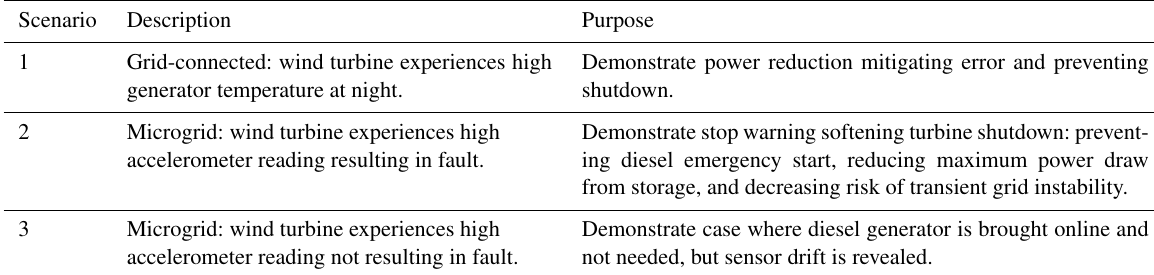
Figure 6. Case 2 scope. Speed sensor warning anticipates fault, which would give the grid operator time to react. (a) HSS/LSS speed difference, with fault and warning thresholds. (c) HSS/LSS torque difference, with fault and warning thresholds. (e) Power prediction, command, and output. (b) Mode value: 0 = no warning, 1 = wait warning, 5 = wait warning + stop warning, 8 = normal stop. (d) Timers. Stop and wait timers start counting up when stop and wait warning modes are activated, respectively, then reset when the wind turbine shuts down. Table 4. Scenarios demonstrating FIRC benefit over a baseline